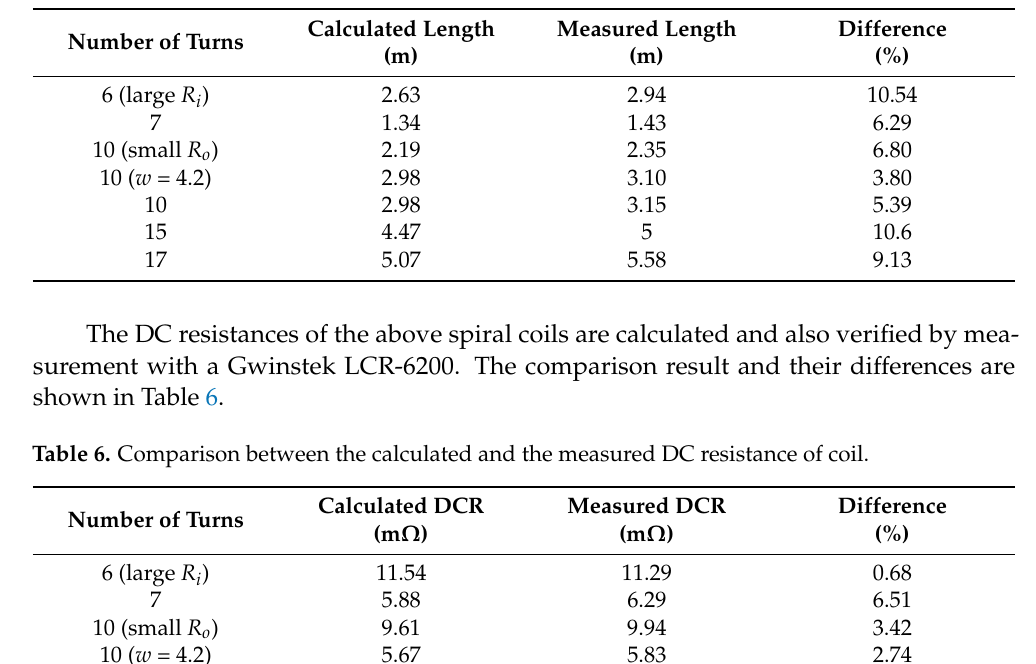
Table 5. Comparison between the calculated and the measured length.